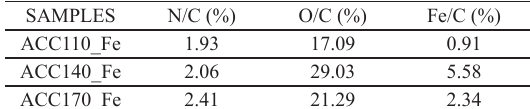
Table 2. N/C, O/C, and Fe/C ratios calculated for the